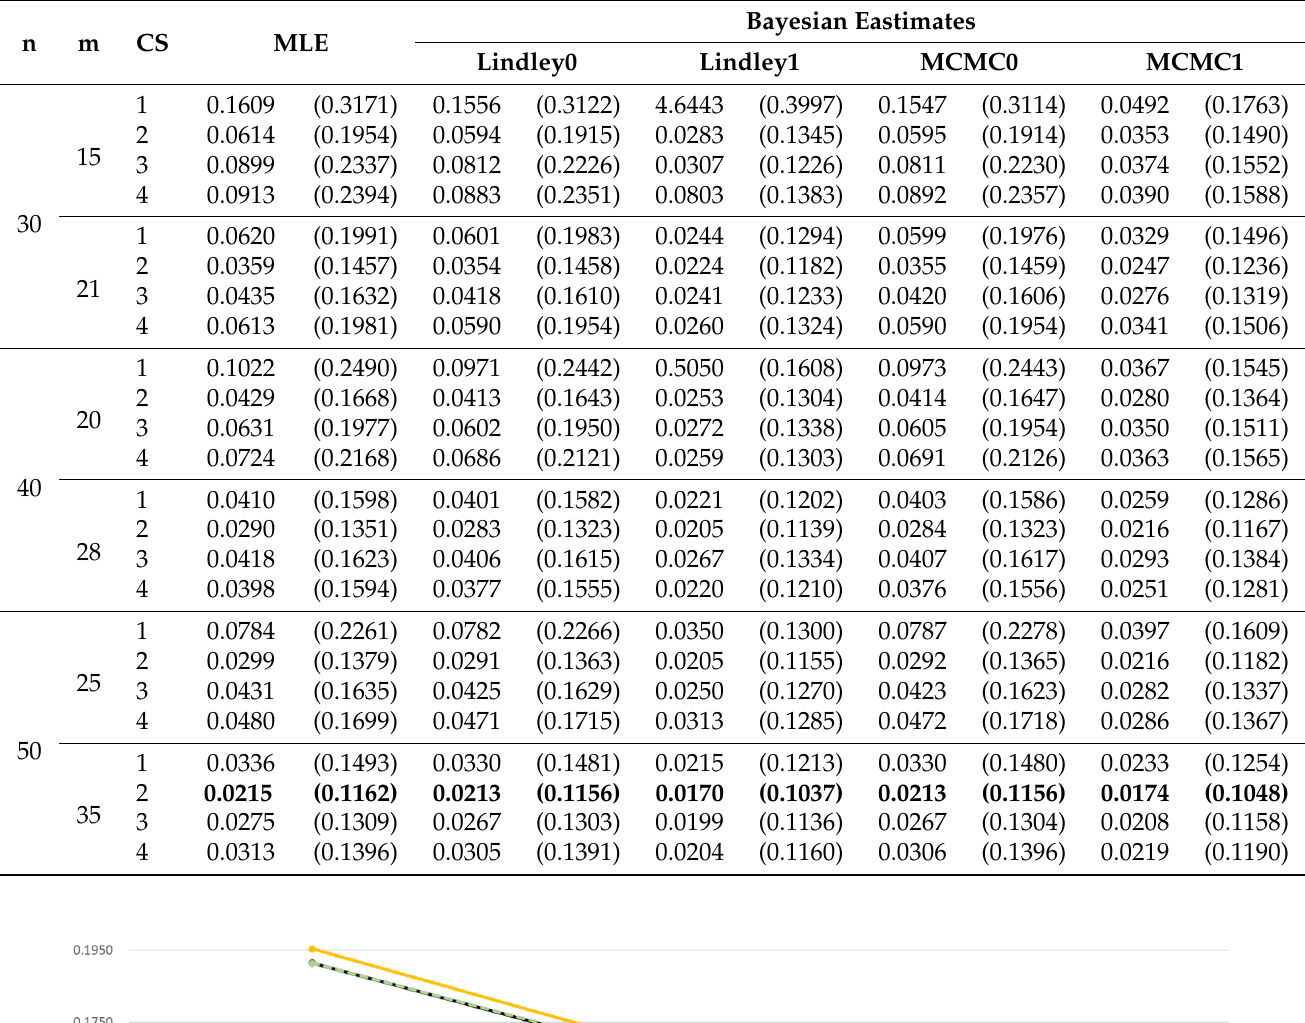
Table 2. MSEs and ABs (in brackets) of ML and Bayesian estimates of entropy for Burr XII distribution with α = 3 and β = 2 under different censoring schemes (CS). The hyperparemeters for gamma prior are a = 3, b = 1, c = 2 and d = 1.